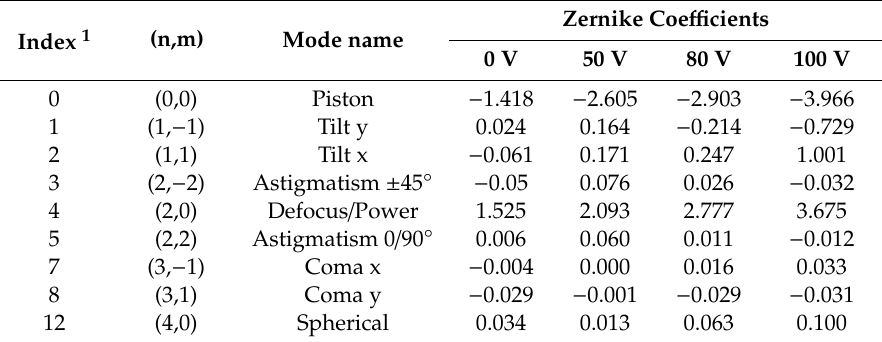
Table 1. Zernike coefficients (in µm) of our lens at different applied voltages, corresponding to the wavefronts shown in Figure 6. Note that n refers to the radial order of the polynomial and m refers to angular frequency.